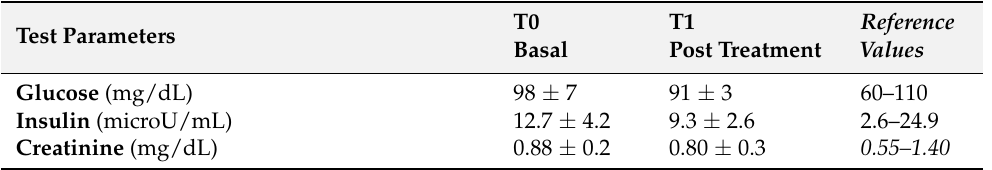
Table 4. Main blood values of patients before the beginning of the treatment with nutraceutical preparation (T0) and after three months of treatment